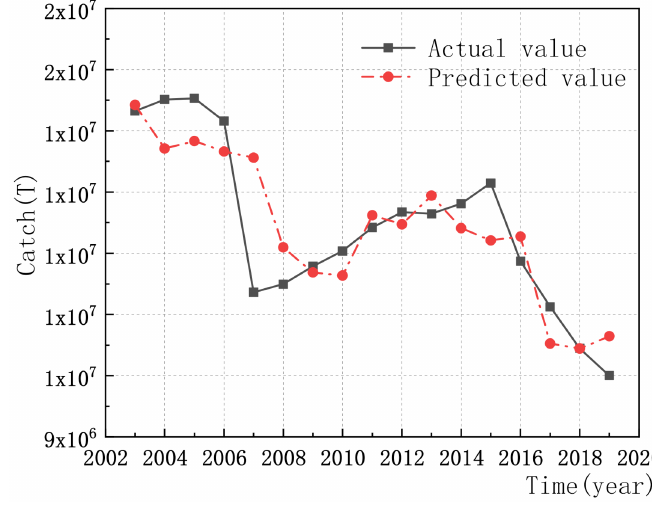
Figure 5. Lasso regression.